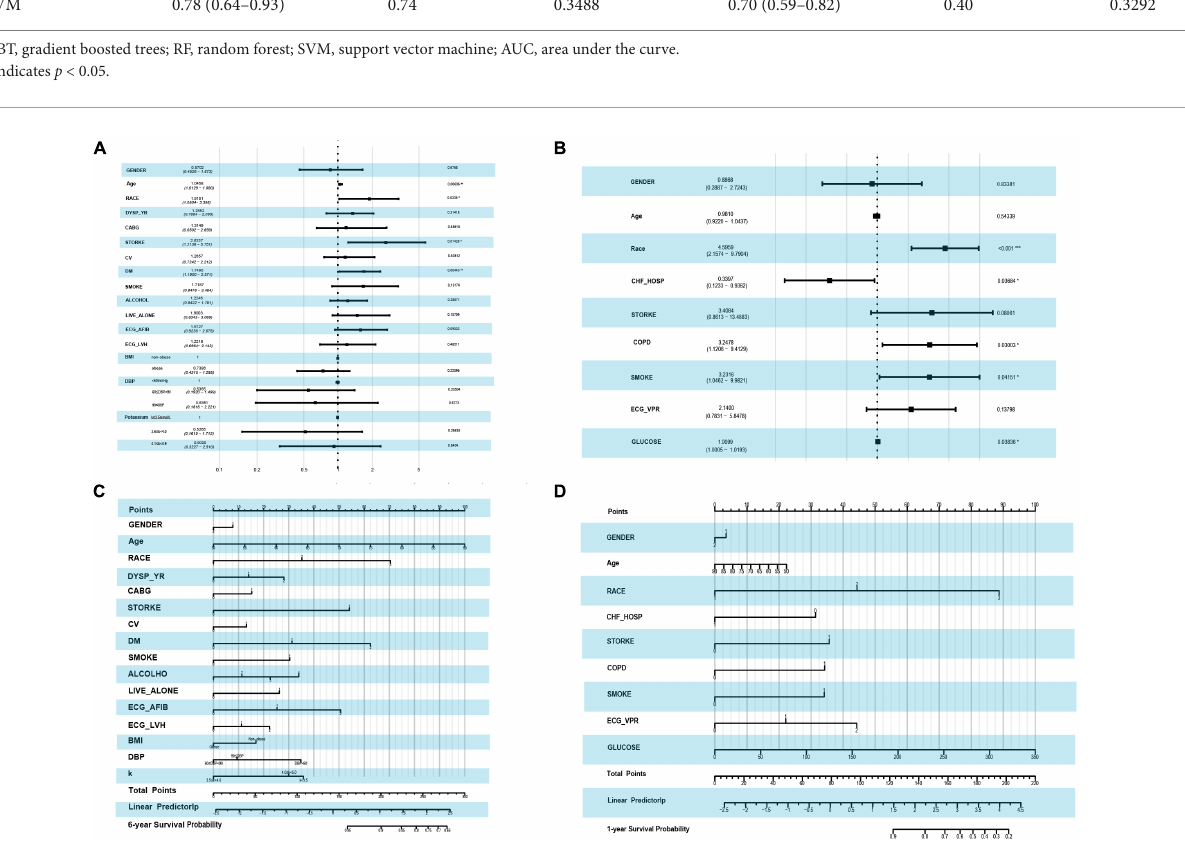
FIGURE3 Forest plot by using the multi-variable COX regression and the risk score nomogram. (A) Forest plot of variables selected by LASSO COX regression in the end point event of all-cause mortality at 6-year follow-up. (B) Forest plot of variables selected by LASSO in the end point event of all-cause mortality at 1-year follow-up. (C) Nomogram for predicting 6-year all-cause mortality based on variables selected by LASSO COX regression. (D) Nomogram for predicting 1-year all-cause mortality based on variables selected by LASSO COX